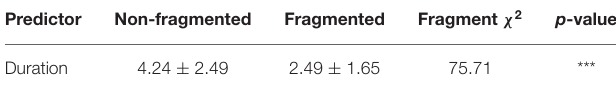
TABLE 4 | LMM on utterance duration in Fragment (NoF-F) fixed